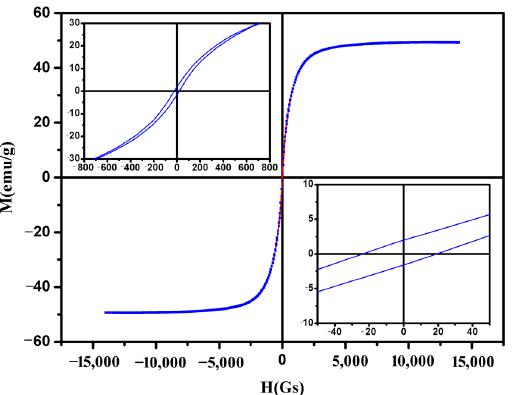
Figure 2. The magnetic hysteresis curves of amorphous magnetic Fe − Ni − B